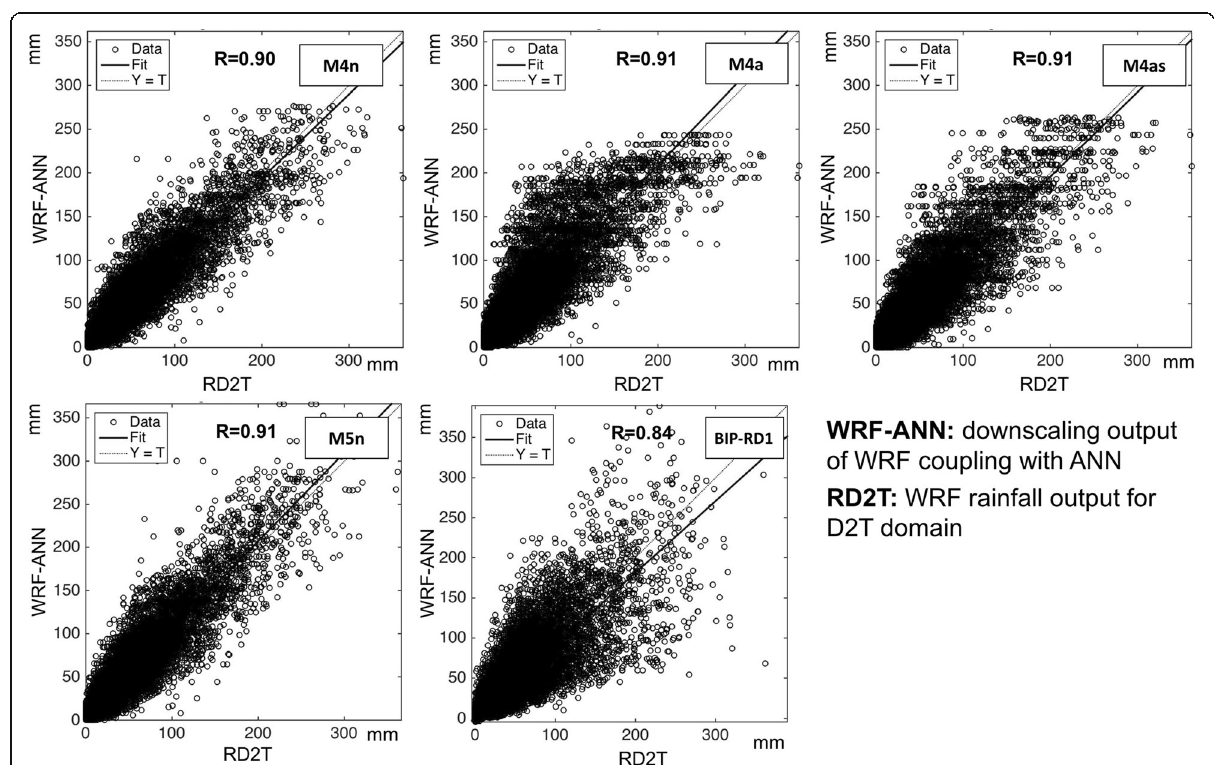
Fig. 6 Regression plots for target and forecasted rainfall in